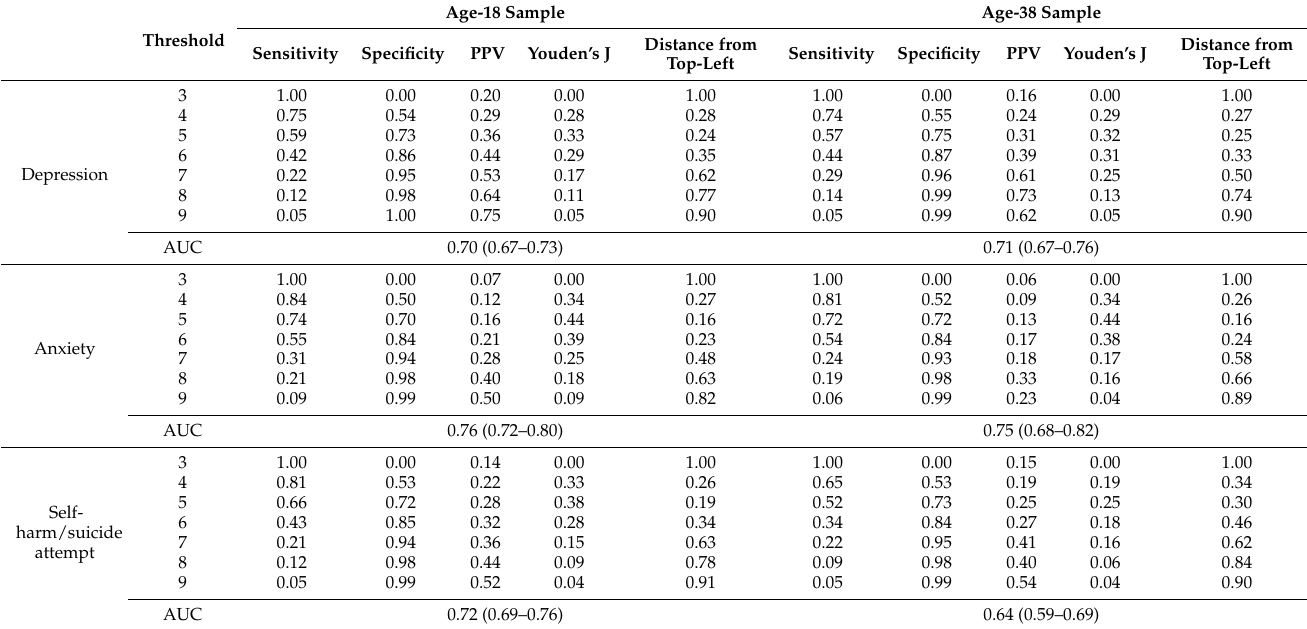
Table 2. Accuracy of the 3-item UCLA Loneliness Scale in classifying mental health